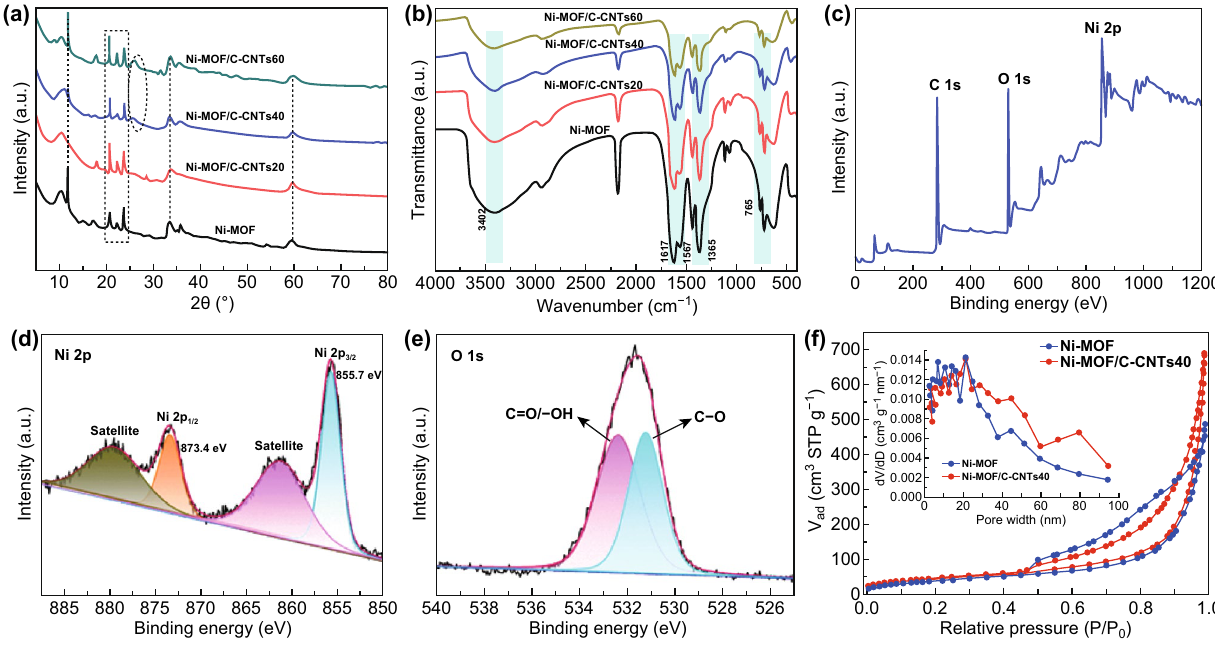
Fig. 3 Physical characterization of as-synthesized samples. a XRD patterns and b FT-IR spectra of Ni-MOF and a series of Ni-MOF/C-CNTs nanostructures. c XPS spectrum of Ni-MOF/C-CNTs40. High-resolution XPS spectra of d Ni 2p and e O 1 s. f N 2 adsorption–desorption iso- therms and pore size distribution plots (inset) of Ni-MOF and